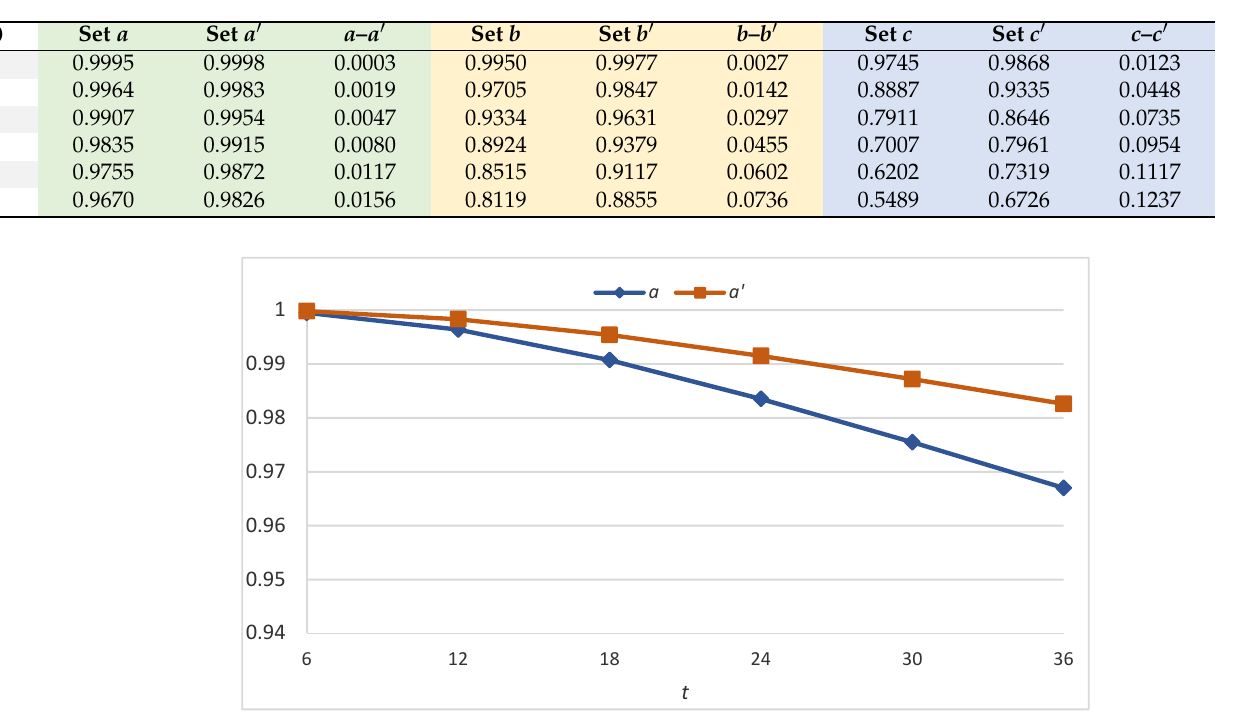
Table 2. Bitcoin dependability and comparisons.